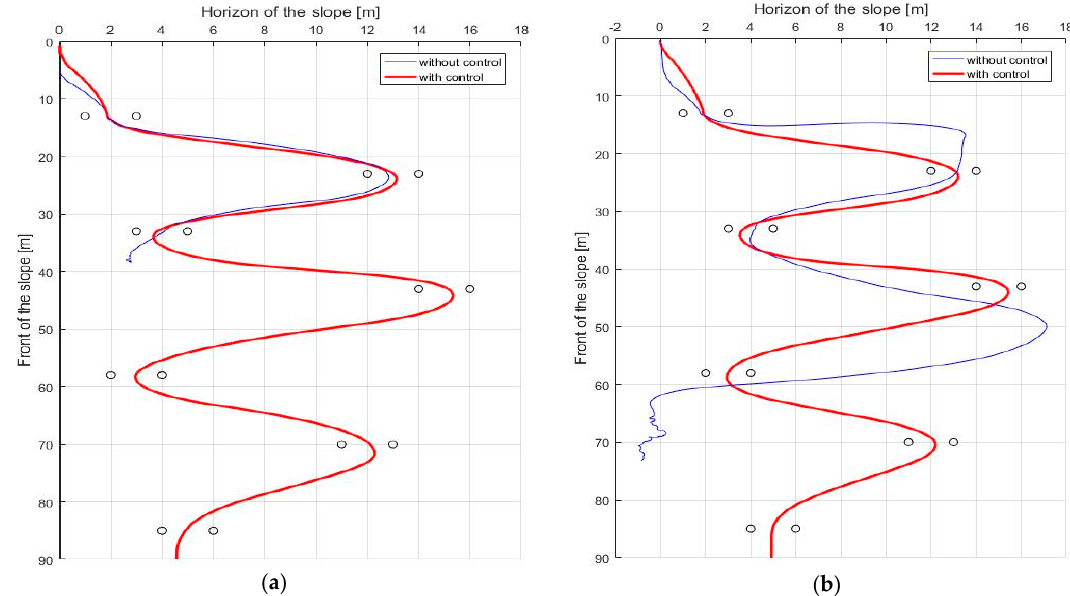
Figure 13. The results of the ZMP control in long interval gates ( a ) 𝜇 (cid:3046)(cid:3039)(cid:3042)(cid:3043)(cid:3032) = 0.09 , 𝛼 = 8° ; ( b ) 𝜇 (cid:3046)(cid:3039)(cid:3042)(cid:3043)(cid:3032) = 0.12, 𝛼 = 10° .